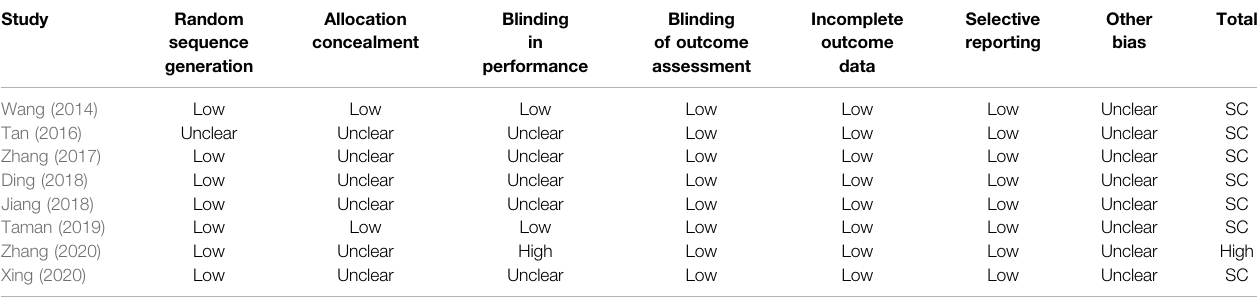
TABLE 3 | Risk of bias evaluation of the included